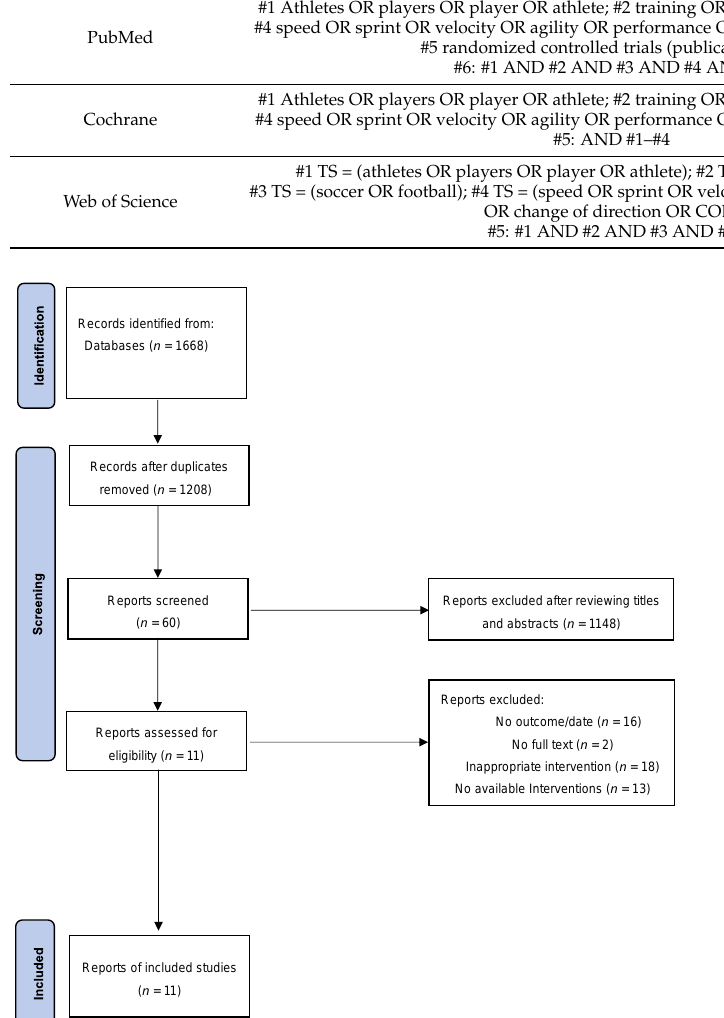
Figure 1. PRISMA flowchart for inclusion and exclusion of studies.